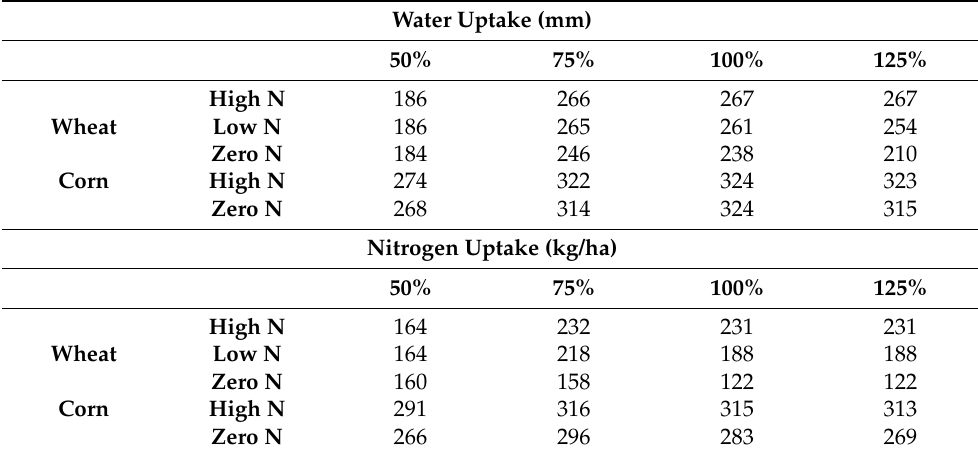
Table 4. Simulated total water uptake (mm) and N uptake (kg/ha) from the soil profiles for wheat and corn over the growing